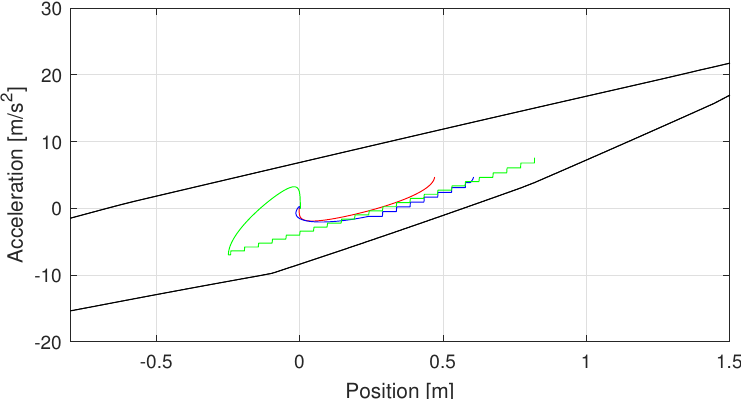
Figure 4. Three different trajectories: depending on the starting point, to respect the acceleration limits, the trajectory is feasible ( red ), must be modified but the end-effector stops at the SP ( blue ), or goes beyond and must turn back ( green